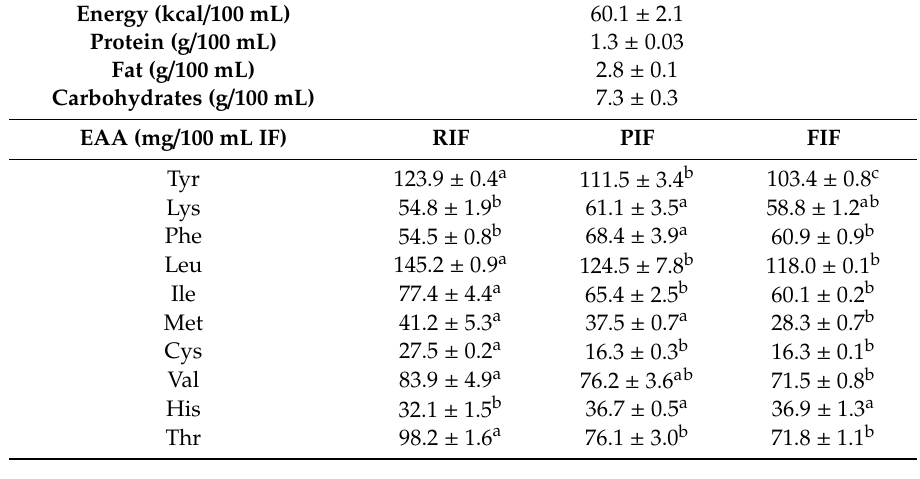
Table 2. Nutritional composition of the three reconstituted infant formulas (IFs): RIF (reference infant formula), PIF (pea infant formula), and FIF (faba bean infant formula). Essential amino acid (EAA) composition is expressed in mg amino acid / 100 mL infant formula. Data are means ± SD ( n = 2). Di ff erent superscript letters indicate statistically significant di ff erence ( p < 0.05).